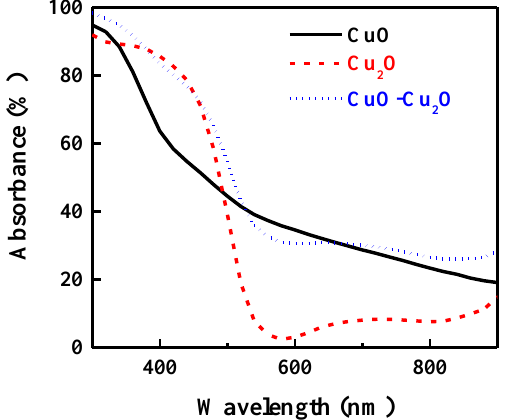
Figure 4. Absorbance spectra of the CuO, Cu 2 O, and the heterojunction CuO – Cu 2 O thin films.